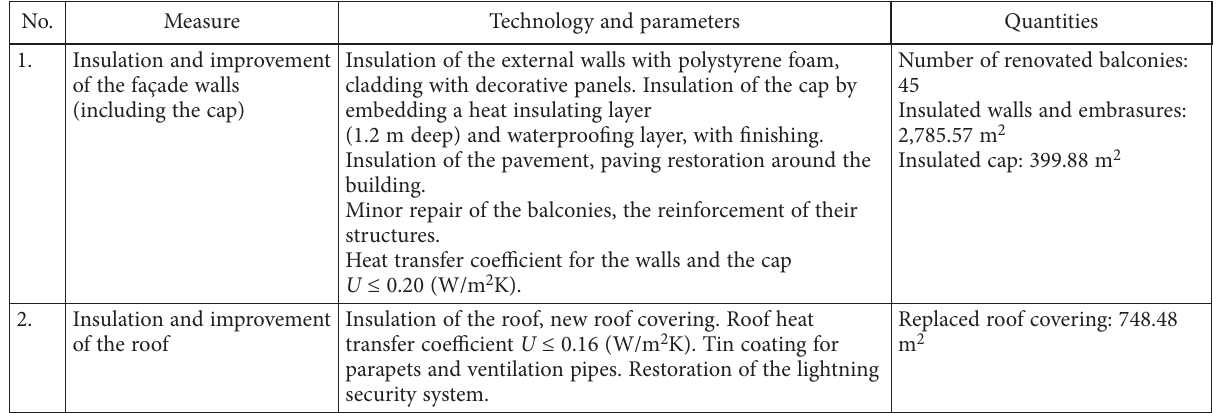
Table 10. Proposed refurbishment measures for Alternative